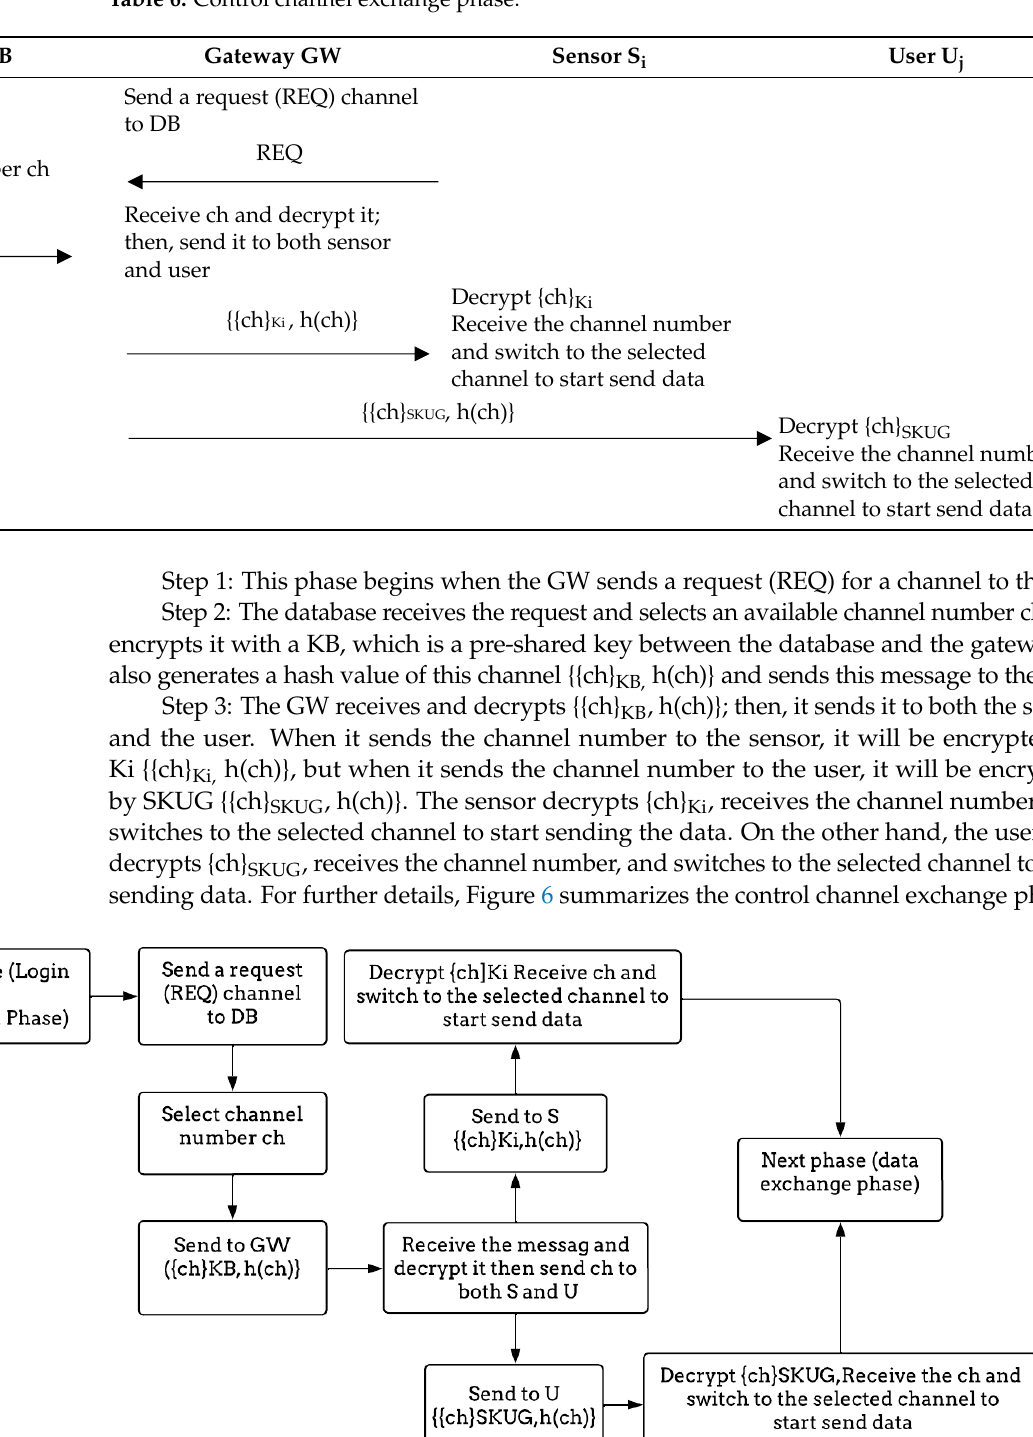
Table 6. Control channel exchange phase.